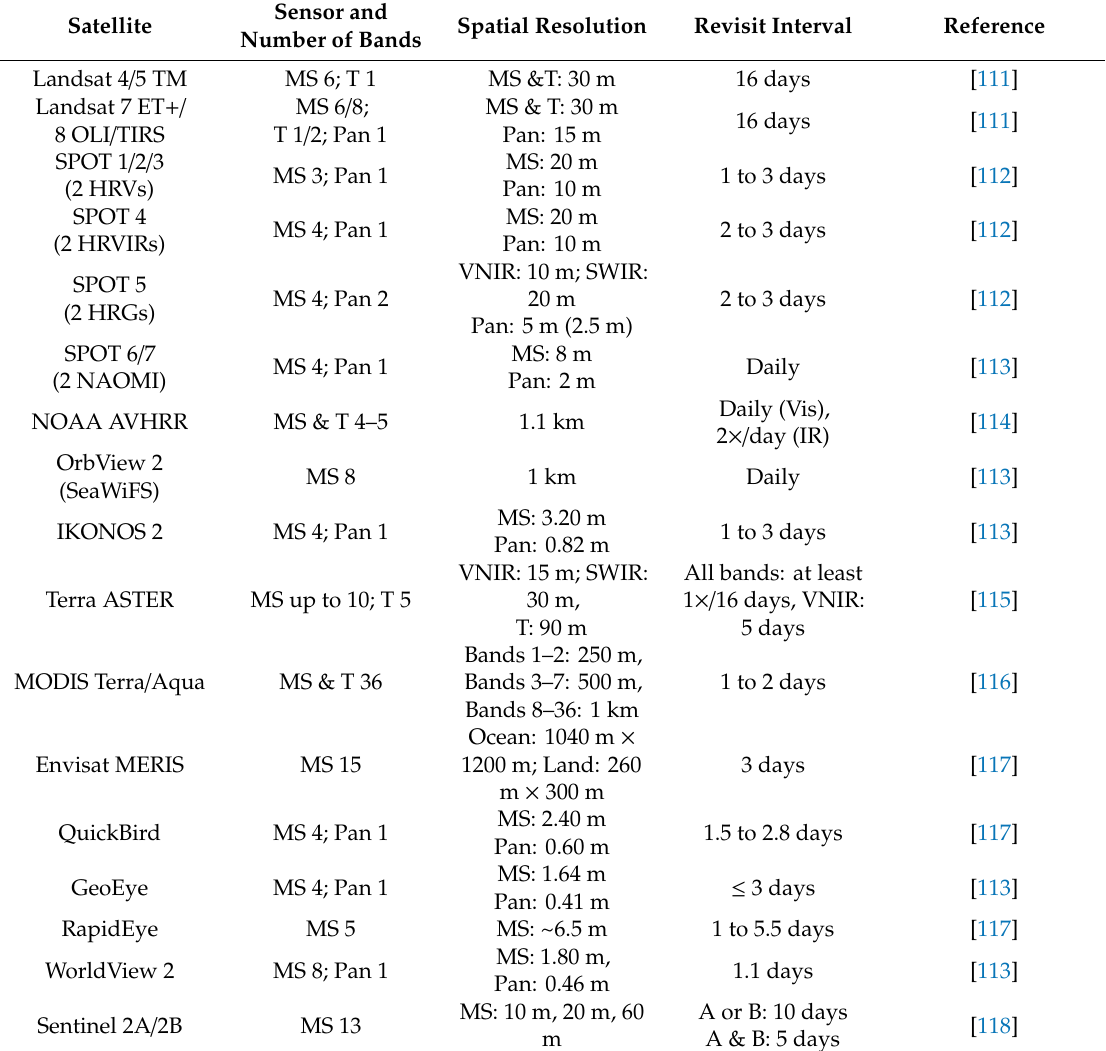
Table A1. Widely used multispectral satellite RS data.